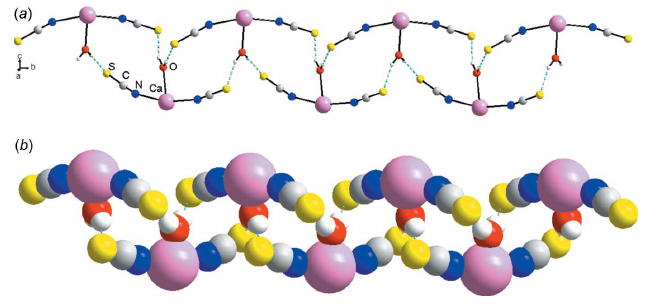
Figure 4 Fragment of the crystal structure of the title compound, illustrating the chain skeleton based on the [ R 2 ( b ) space-filling mode.